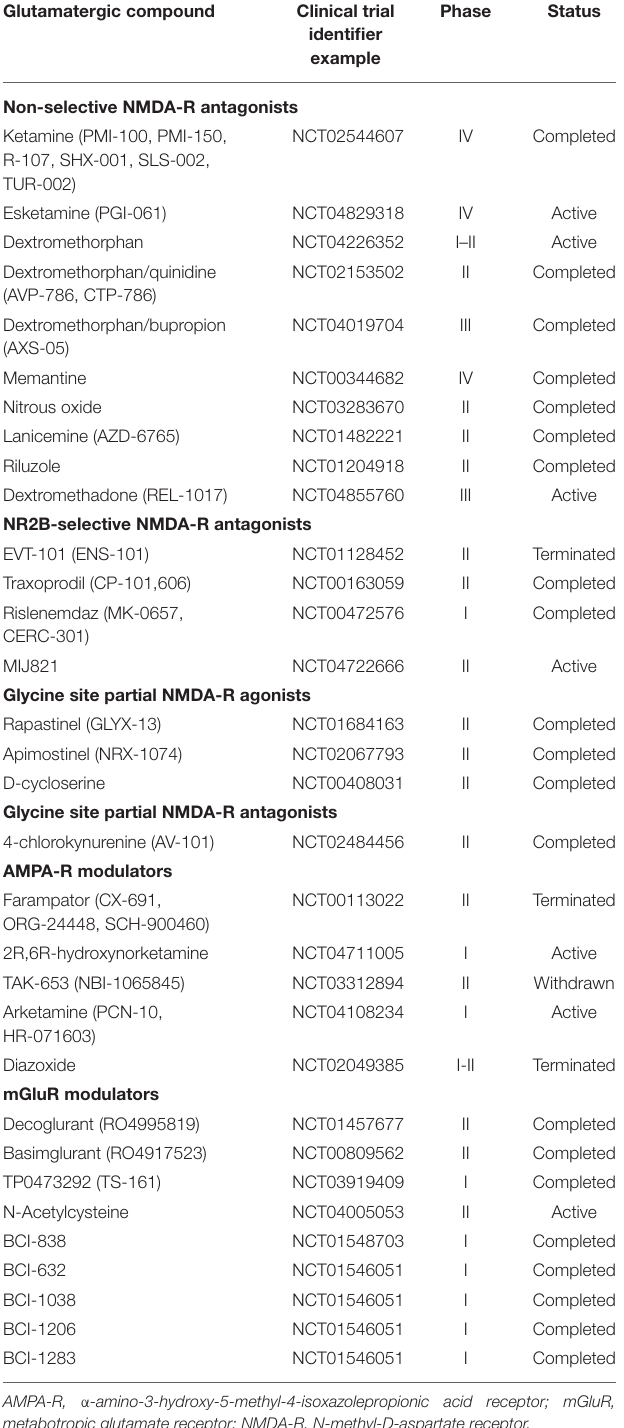
TABLE 1 | Glutamate-mediating drug candidates for major depressive disorder. Glutamatergic